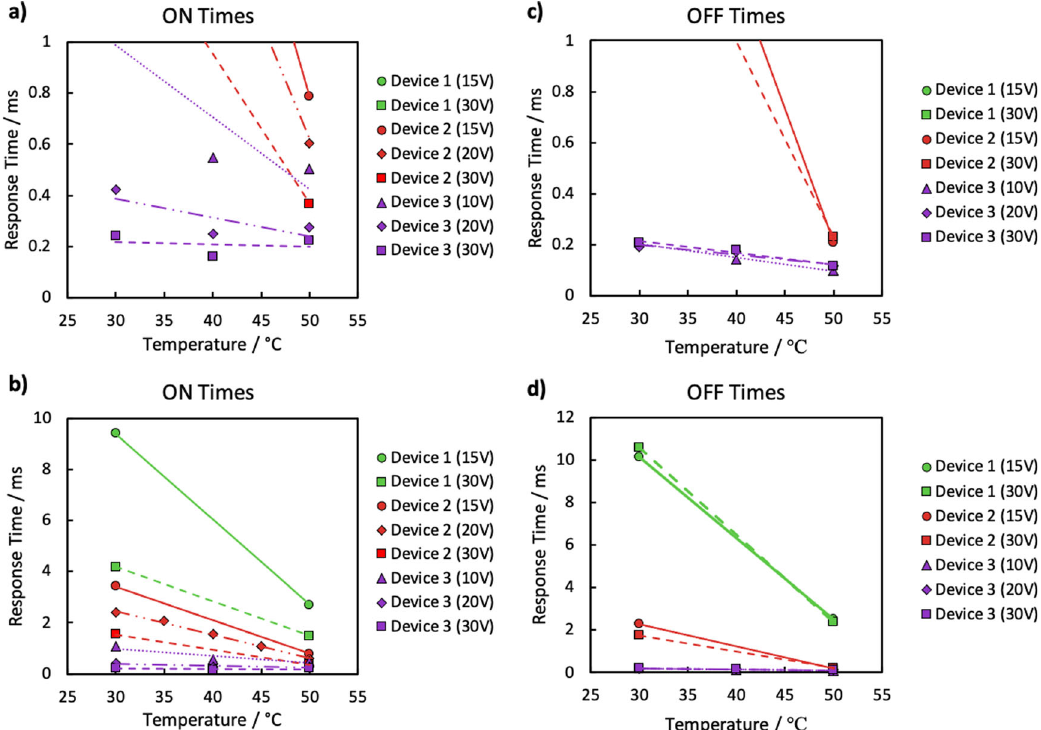
Fig. 8 Response times for prototype VGA-FLC devices. The response times for three VGA-FLC devices (Table 1) versus temperature for various applied voltages. Measurements were made with ON and OFF pulses of the same but opposite magnitude voltage. a , b ON times for Device 1 and c , d OFF times. All lines of best fi t are guides for the eye representing Eq. (5), however, are not necessarily expected to be linear due to the rotational viscosity also showing non-linear temperature dependence. Further details are given in Supplementary